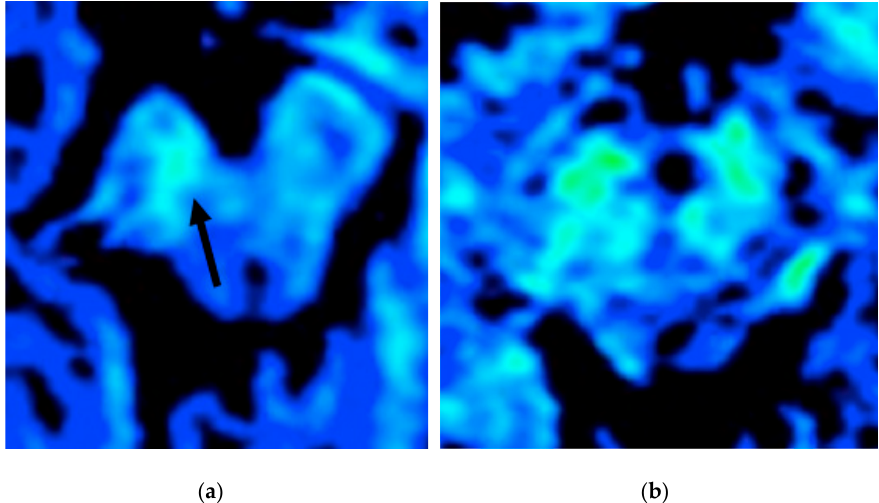
Figure 5. T2* map study (color scale) of two patients with PD in an evaluation of iron deposition within the SN (blue: less iron deposition; green: more iron deposition). The patient in ( a ) has a more evident asymmetrical iron deposition when compared to the patient in ( b ).